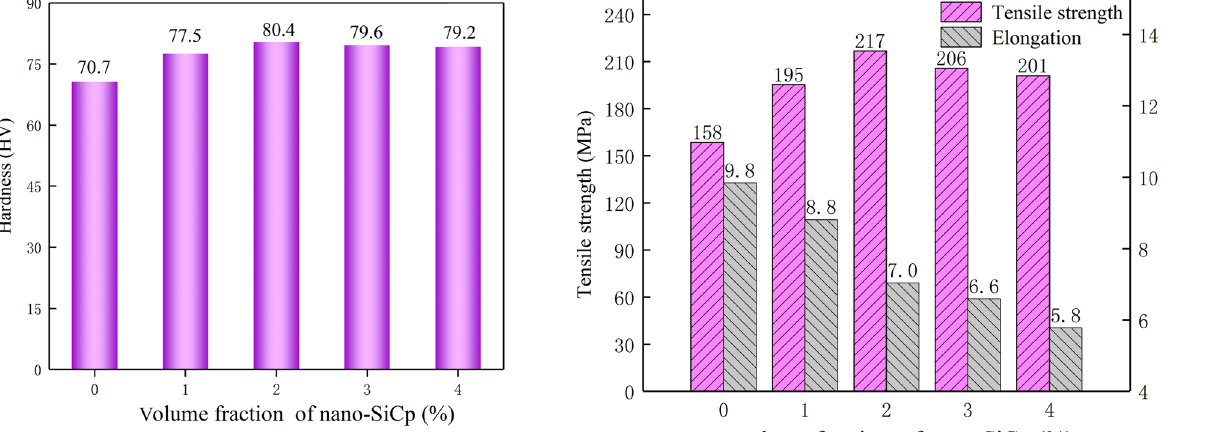
Figure 4: Hardness of nanocomposites with di ff erent SiCp volume fractions.